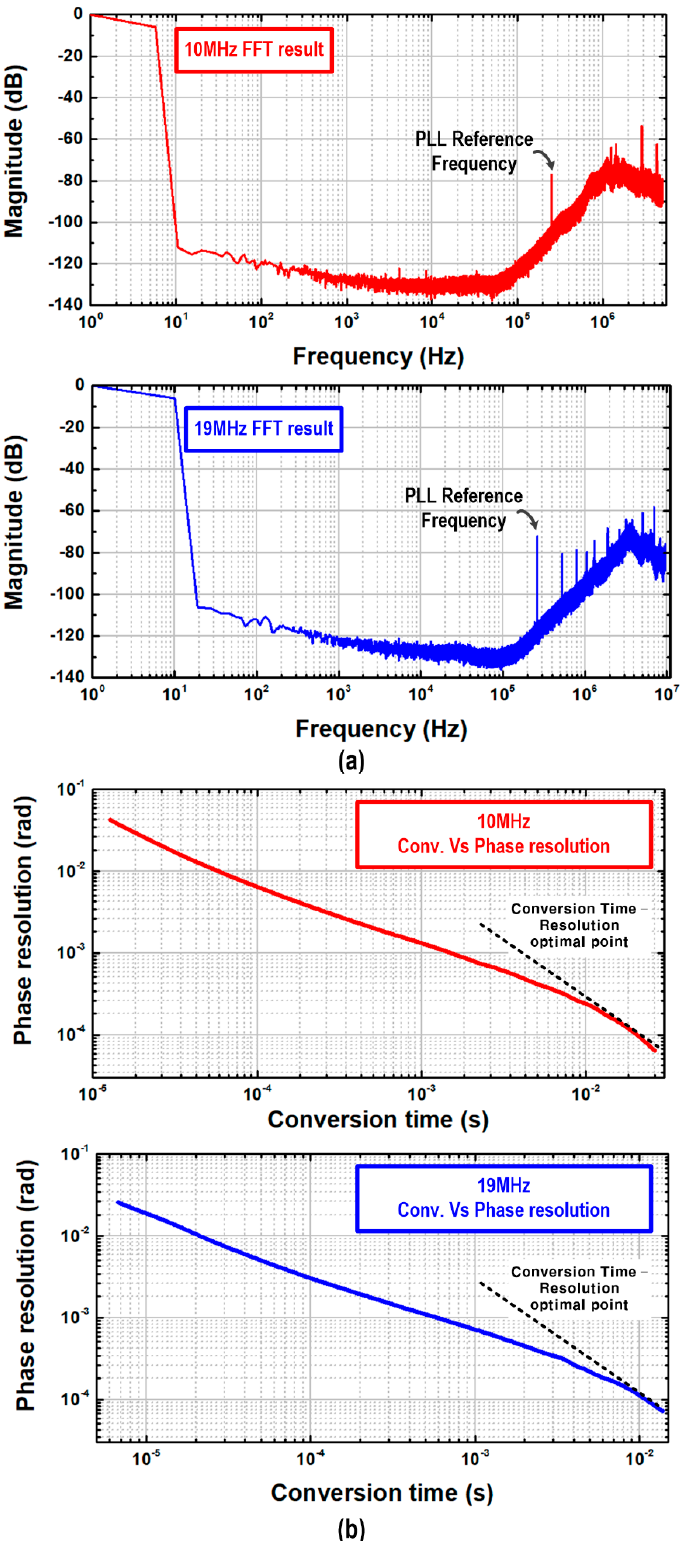
Figure 7. ( a ) Measured fast fourier transform (FFT) plot of phase-domain sigma-delta modulator and ( b ) measured characteristic plot on phase resolution versus conversion time.